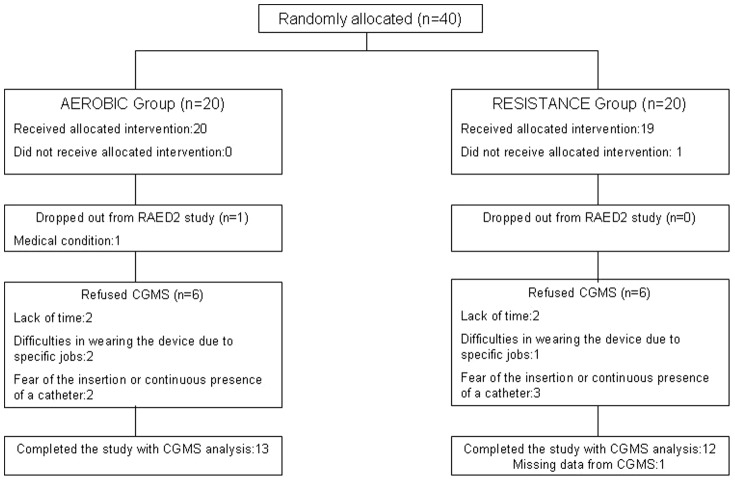
Study flow diagram.